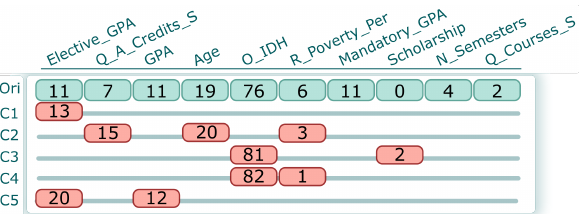
Figure 5. A block in the Counterfactual Exploration view, with the original values (row Ori) and five corresponding counterfactuals (rows C1 to C5). Based on this block, we have five options to keep the student in the college. For instance, in C1, it is enough to improve the elective GPA from 11 to 13 (0–20 scale) to avoid the student dropping out of the